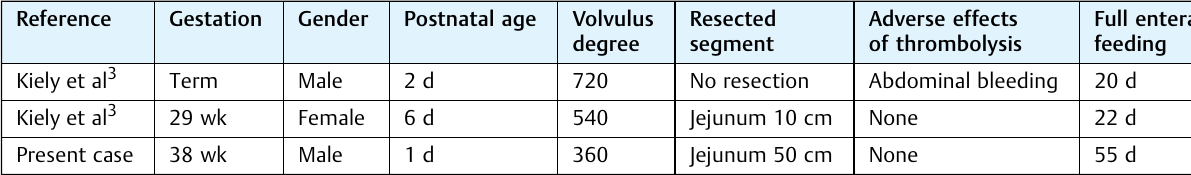
Table 2 Clinical characteristics of neonates treated with thrombolysis